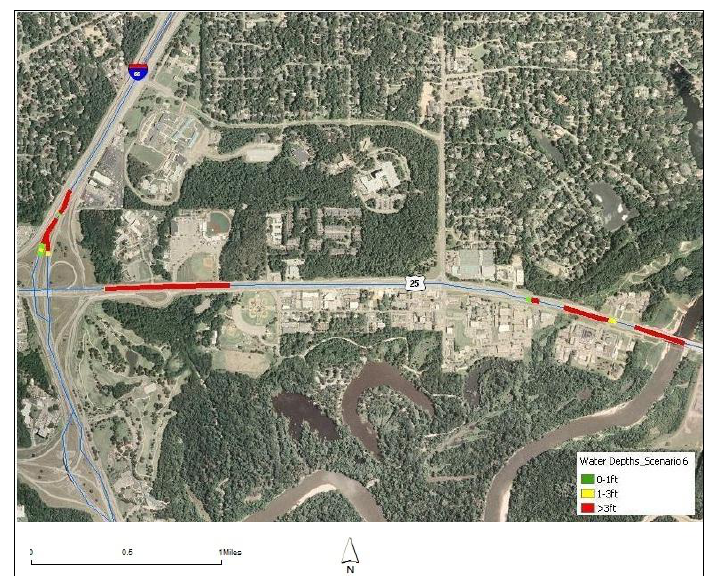
Figure 19. Depth of the flood waters on Lake Land Drive.